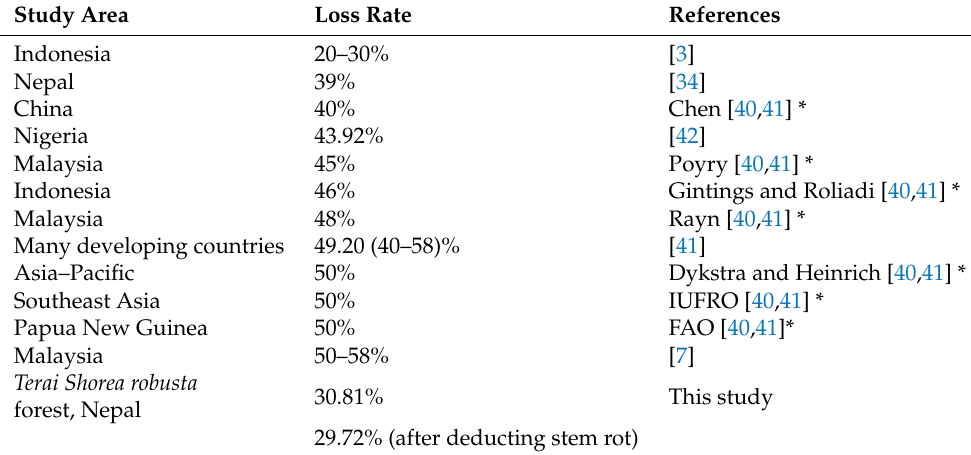
Table 6. Rates of timber loss while converting round logs into sawn-wood as estimated by timber utilization studies conducted in various